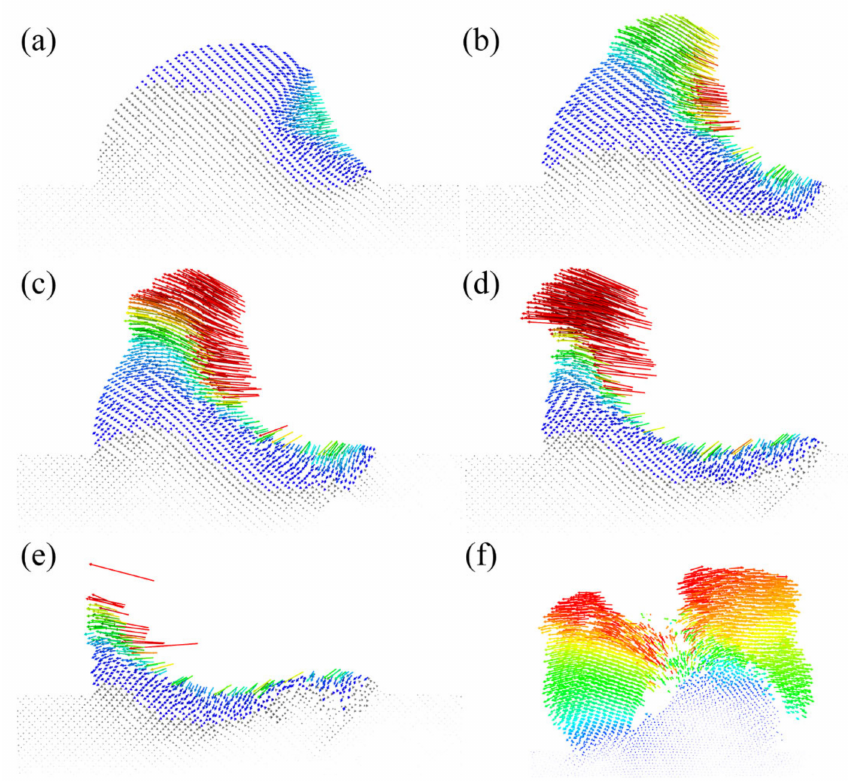
Figure 5. Atomic displacement vector diagram in different plowing stages; ( a – e ) represent the plowing distance of d = 4 nm, 7 nm, 9 nm, 12 nm and 14 nm. Additionally, ( f ) shows a view of the crack plane at 12 nm distance, demonstrating the trajectory of the atoms on either side of the crack. The direction of the arrow indicates the moving direction of atoms and the color of the arrow indicates the magnitude of the displacement.